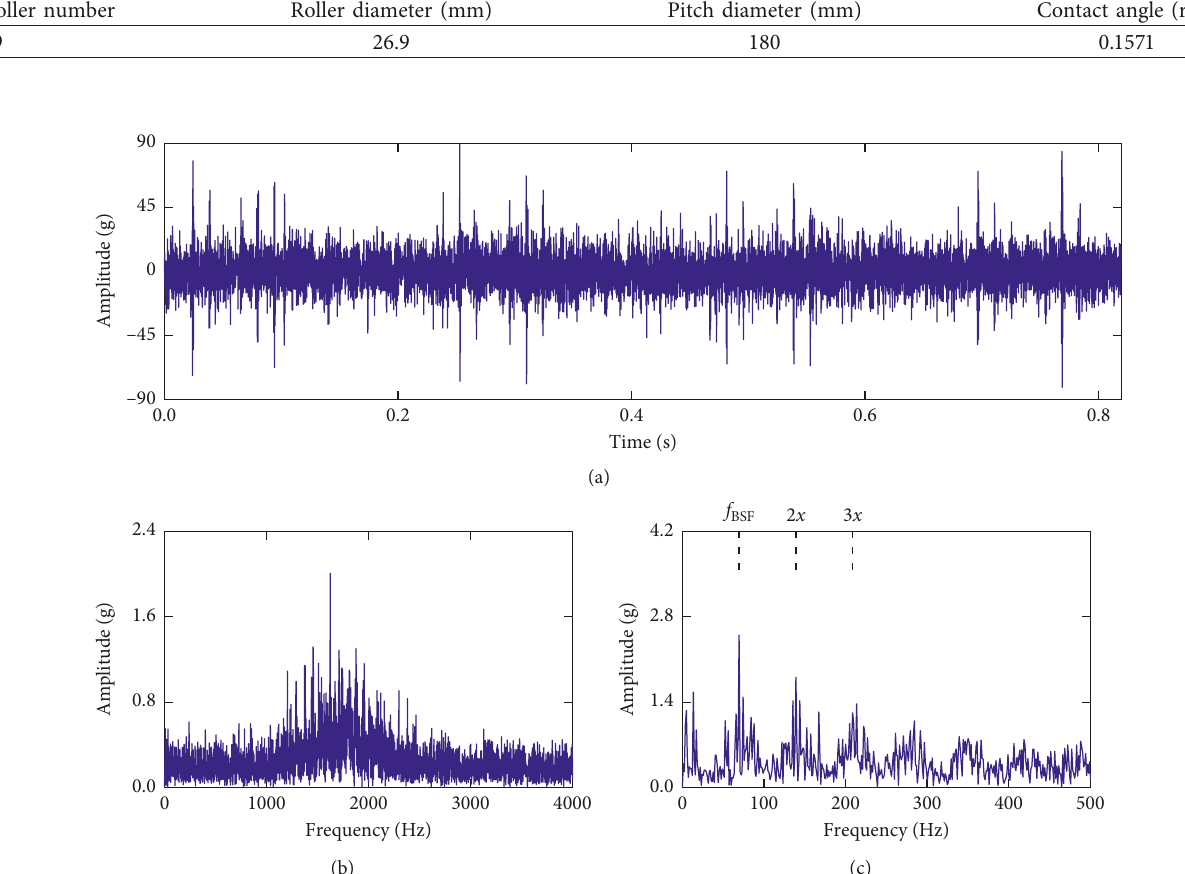
Figure 12: Collected vibration signal for the bench test: (a) time-domain waveform; (b) Fourier spectrum of (a); (c) Hilbert envelope spectrum of (b).